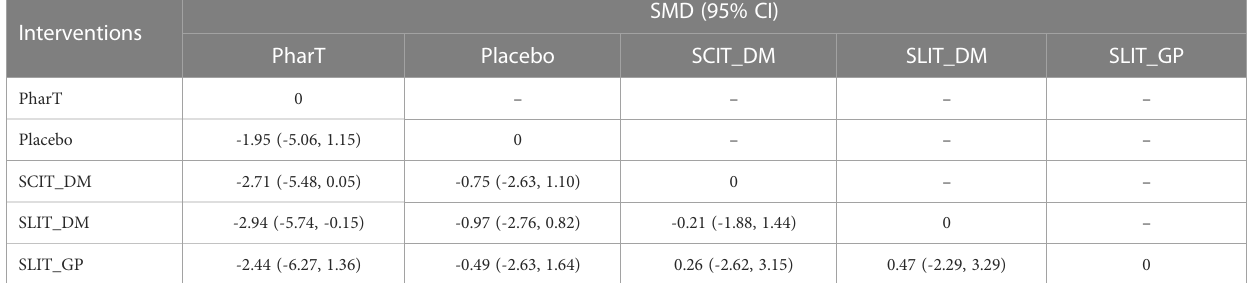
TABLE 2 Network meta-analysis of symptom scores.